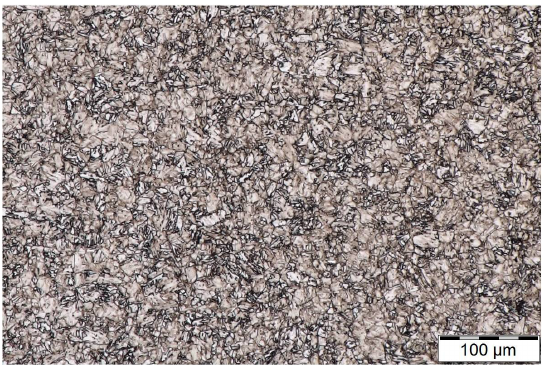
Figure 1. Microstructure of heat-treated specimen. Magnification, 500×.